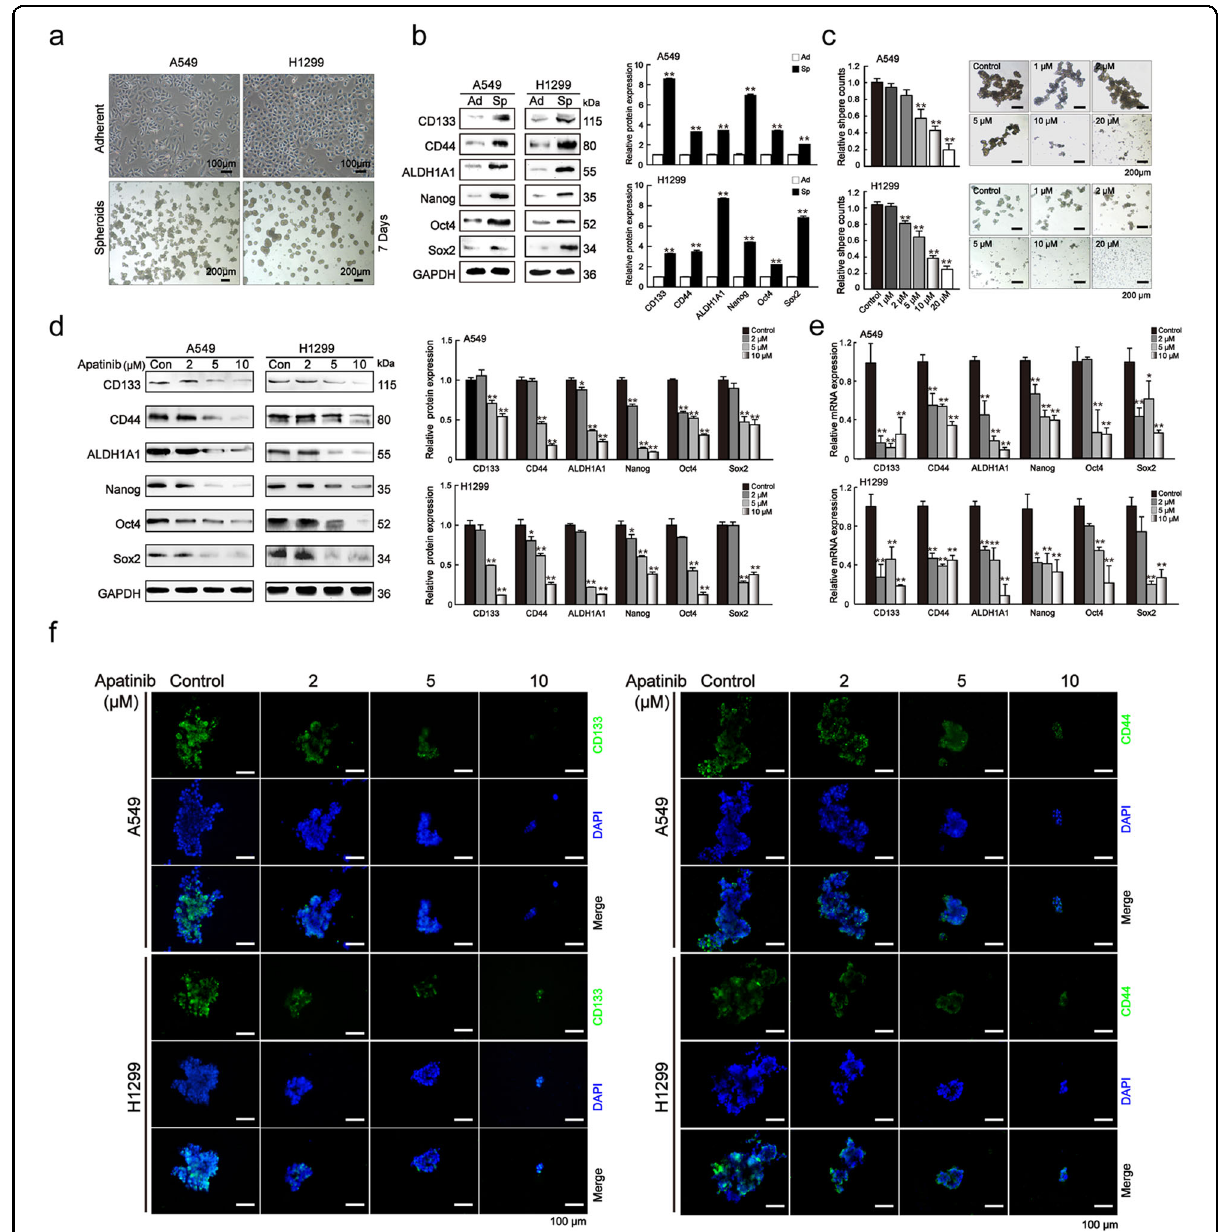
Fig. 1 Apatinib inhibited lung CSC-like properties. a Sphere-forming capacities of A549 and H1299 cells. Scale bar = 100 μ m in adherent group, scale bar = 200 μ m in spheroids group. b Protein levels of lung CSC-related markers (CD133, CD44, and ALDH1A1) and stemness-related genes (Nanog, Oct4, and Sox2) in adherent cells and spheroids on day 7. Ad adherent cells, Sp spheroids. Unpaired t -test was used. Data are presented as mean ± SD ( n = 3). ** p < 0.01 compared to the control group. c Sphere-forming capacities of A549 and H1299 cells treated by apatinib at various concentrations (0, 1, 2, 5, 10, and 20 μ M) on day 7. Scale bar = 200 μ m. One-way ANOVA (Bonferroni ’ s multiple-comparison test) was used. Data are presented as mean ± SD ( n = 3). ** p < 0.01 compared to the control group. d Protein levels of lung CSC markers in spheroids on day 7 after apatinib treatment. One-way ANOVA (Bonferroni ’ s multiple-comparison test) was used. Data are presented as mean ± SD ( n = 3). * p < 0.05, ** p < 0.01 compared to the control group. e mRNA expression of lung CSC markers in spheroids on day 7 after apatinib treatment. One-way ANOVA (Bonferroni ’ s multiple-comparison test) was used. Data are presented as mean ± SD ( n = 3). * p < 0.05, ** p < 0.01 compared to the control group. f Representative immuno fl uorescence images of CD133 (green) and CD44 (green) in apatinib-treated spheroids. DAPI: blue. Scale bar = 100 μ